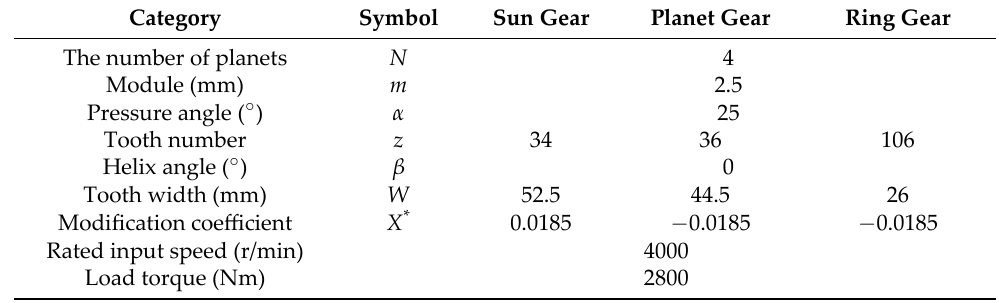
Table 3. Basic parameters of PGT.